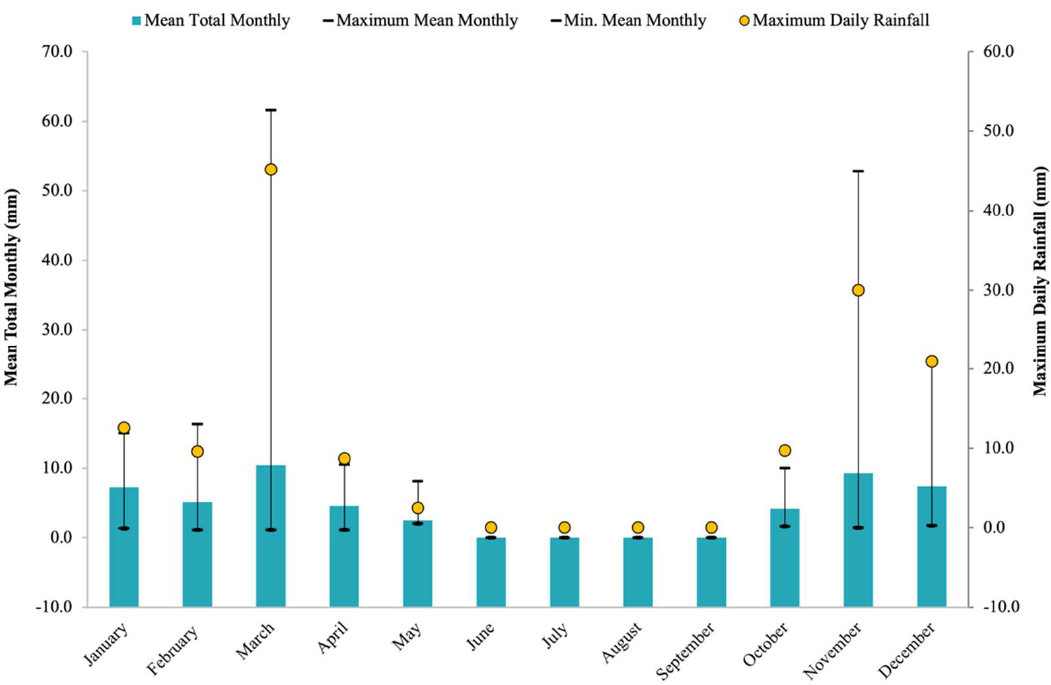
Figure 2. Characteristics of rainfall data from Cairo Airport Station. The average cumulative monthly rainfall data is represented by the histogram, while the horizontal lines represent the maximum and minimum mean monthly data. The yellow oval, on the secondary axis, represents the maximum daily rainfall that occurred each month from the year 1976 to 2020. Table 1. Rainfall corresponds to different return periods used in the study to calculate runoff.